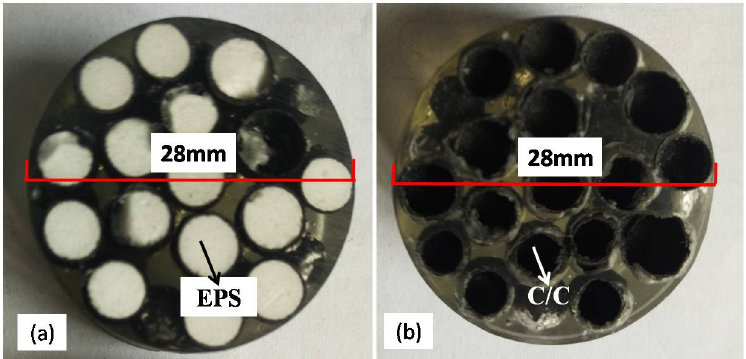
Figure 3. The HCSs ( a ) before carbonization; ( b ) after carbonization.